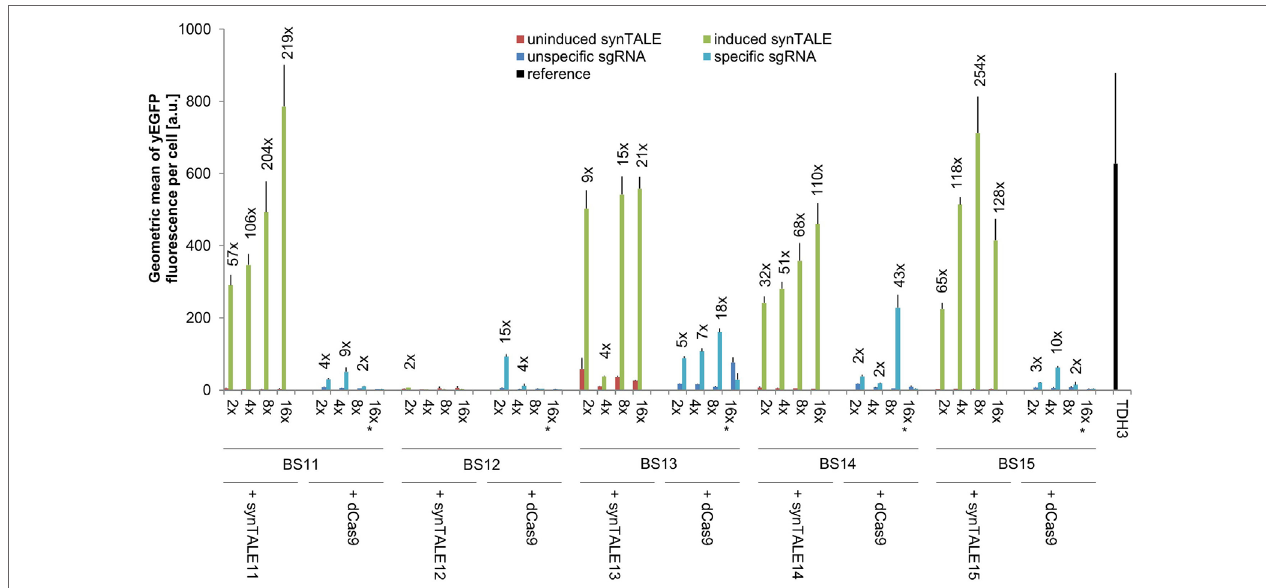
FigUre 4 | Transactivation potential of synthetic transcription activator-like effectors (synTALEs) 11–15 and dCAS-VP64. synTALE11–15 and dead Cas9 (dCas9)-VP64 were tested for their potential to activate yEGFP expression from different synthetic promoters (synPs), each harboring 2, 4, 8, or 16 copies of the corresponding binding site (BS). SynTALE expression was induced with IPTG in galactose containing medium. Background activity of synPs was measured in glucose containing medium without IPTG. dCas9 experiments were done in galactose containing medium with IPTG to promote dCas9 expression. yEGFP fluorescence was measured in the presence of either an single-guide RNA (sgRNA) specific for the synP or an unspecific control sgRNA. Values from uninduced samples are very low. Induction of at least 2-fold is indicated. 2 × , 4 × , 8 × , and 16 × indicate the BS copy number. Fwd, forward orientation; rev, reverse orientation; a.u., arbitrary units. Values are mean values from 3 or 2 (indicated with *) independent